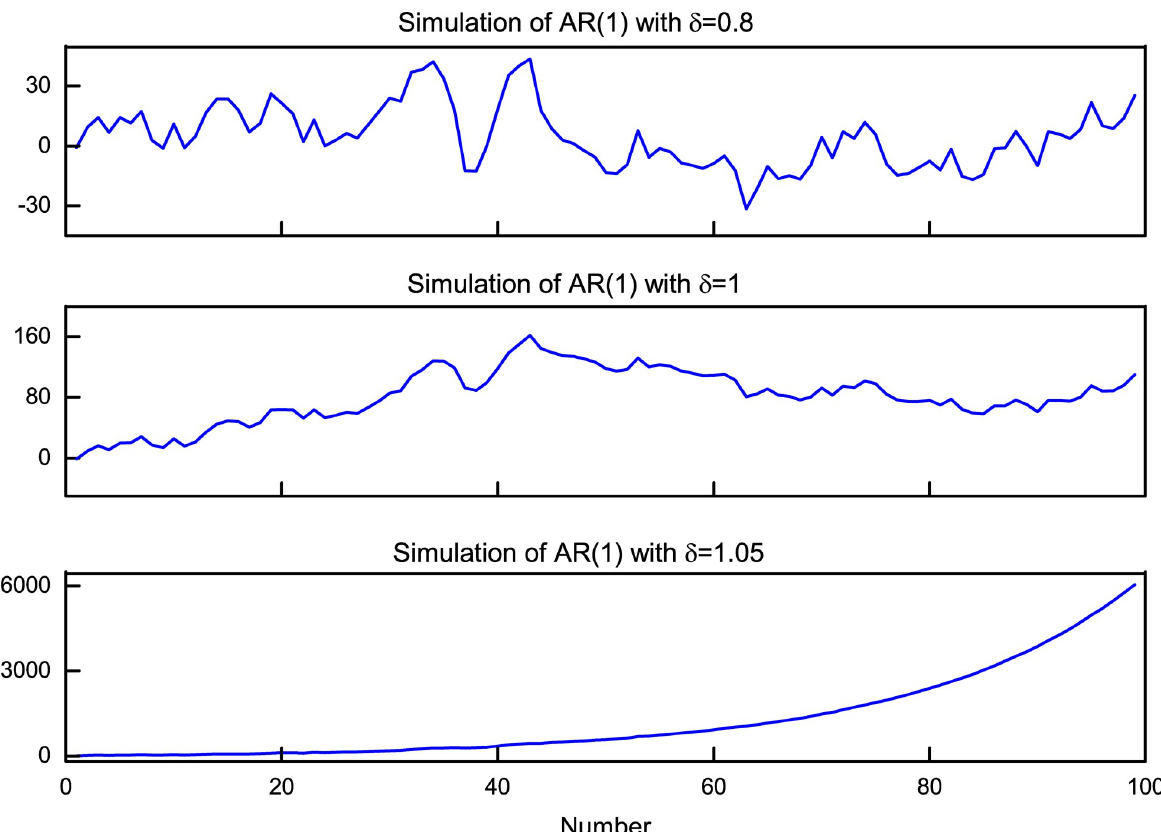
Fig 1. Trajectories of typical stationary, random walk, and explosive autoregressive.